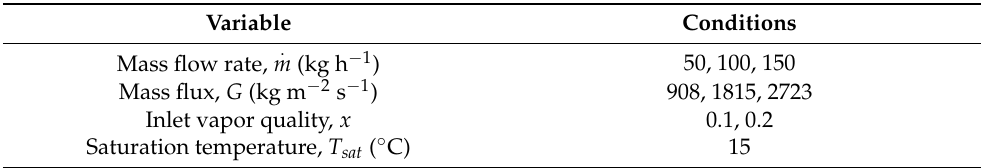
Table 1. Summary of experimental inlet